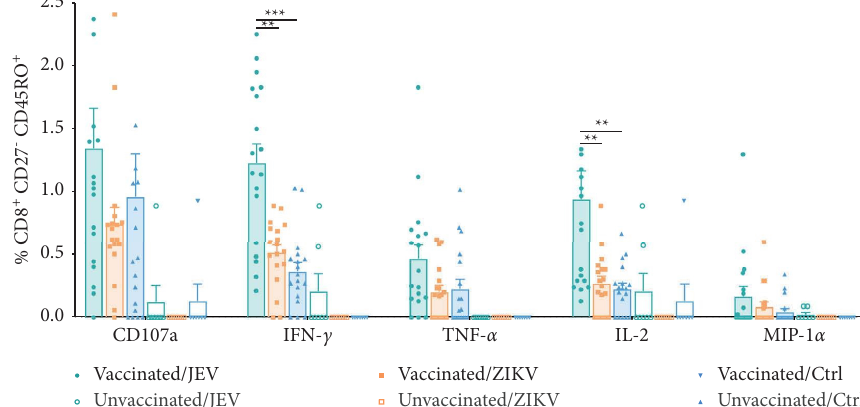
Figure 2: Multifunctional characterization of CD8 + CD27 − CD45RO + efector memory Tcell (T subpopulations were gated on cells expressing at least one of the fve Tcell functions analyzed, and the frequency of cells expressing any of the fve cell functions was assessed. Vaccinated, n � 18; unvaccinated, n � 7. Results are expressed as mean ± SD. Diferences between unmatched groups were compared using an unpaired t -test, the Mann–Whitney U test, or the Kruskal–Wallis rank-sum test with Dunn’s post hoc test for multiple comparisons. ∗∗ P < 0 . 01; ∗∗∗ P < 0 .